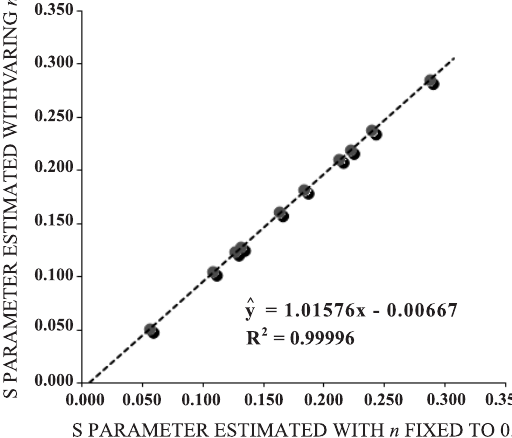
materials.Figure 7. 1:1 plot of Sorptivity (S) estimated with time exponent ( n ) fixed at 0.5 and with time exponent also estimated by